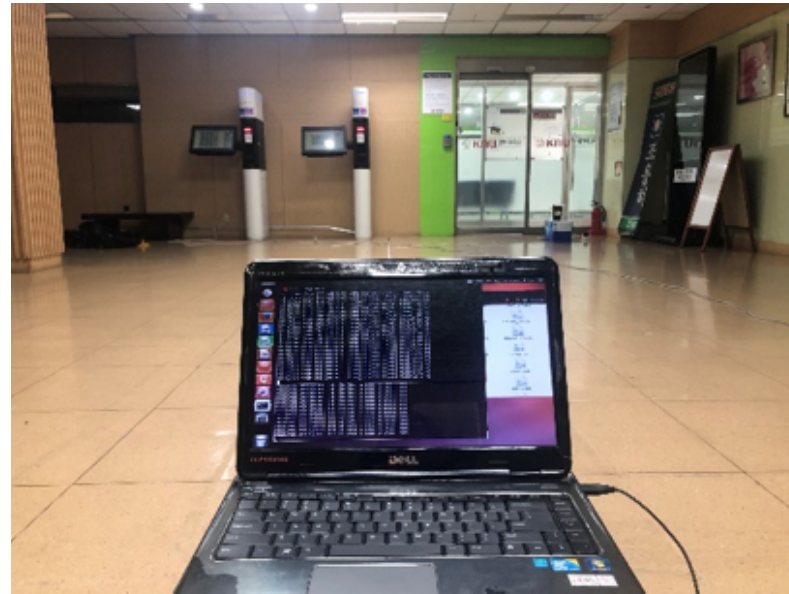
Figure 19. Real lobby environment on the 1st floor of KNU IT-2 building.